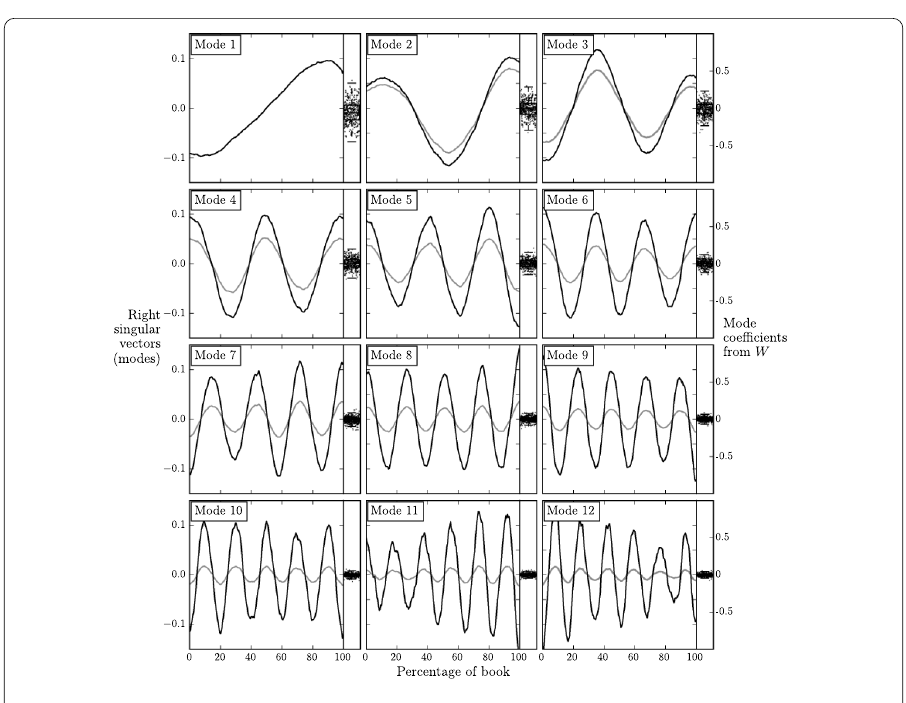
Figure 3 Top 12 modes from the singular value decomposition of 1,327 Project Gutenberg books. We show in a lighter color modes weighted by their corresponding singular value, where we have scaled the matrix (cid:2) such that the first entry is 1 for comparison (for reference, the largest singular value is 34.5). The mode coefficients normalized for each book are shown in the right panel accompanying each mode, in the range –1 to 1, with the ‘Tukey’ box